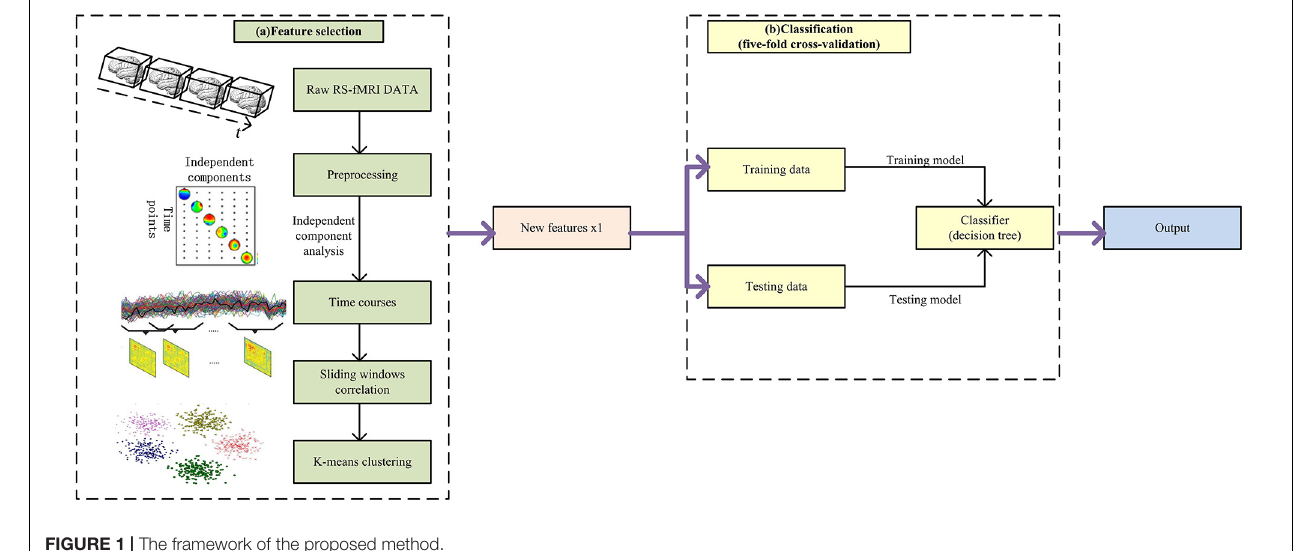
FIGURE 1 | The framework of the proposed method.